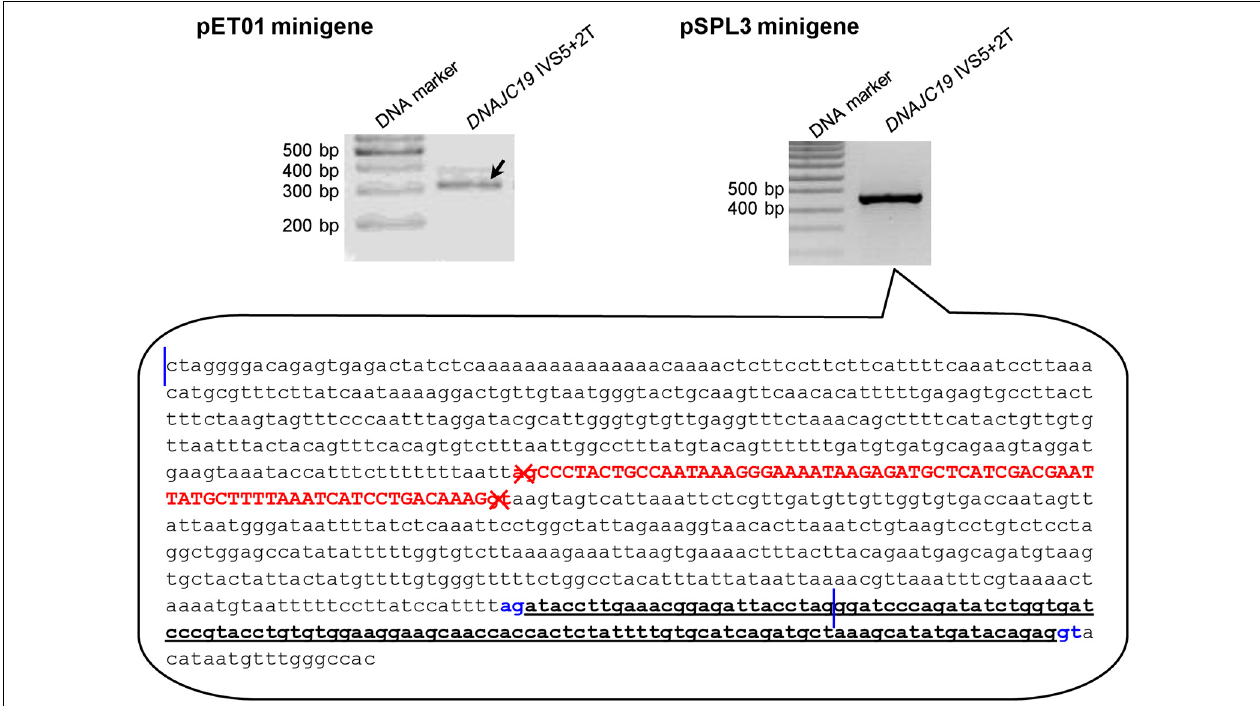
FIGURE 3 | Reverse transcription-polymerase chain reaction results from minigene assays with respect to the DNAJC19 IVS5 + 2T (i.e., wild-type) construct. In the pET01 minigene assay, the DNAJC19 IVS5 + 2T construct yielded the expected wild-type transcripts (indicated by the left oblique downward pointing arrow). In the pSPL3 minigene assay, the DNAJC19 IVS5 + 2T construct yielded an aberrant transcript, whose nature was illustrated in the call-out box. In the call-out box, the sequence delimited by the two vertical blue lines refers to the entire wild-type DNAJC19 DNA insert, which comprised exon 5 (in upper case and in red) and partial intronic sequences on both sides. The sequence downstream of the second vertical line refers to partial downstream pSPL3 vector sequence. The aberrant transcript did not contain DNAJC19 exon 5 but instead contained a 118-bp pseudoexon (in bold and underlined) that spanned the chimeric region of the chimeric intron 2 (see Figure 1A for term definition). The aberrantly inactivated AG-GT splice sites flanking DNAJC19 exon 5 are highlighted in red and denoted by crosses. The aberrantly activated cryptic AG-GT splice sites are highlighted in blue. See Supplementary Figure 5 for the full gel photographs.